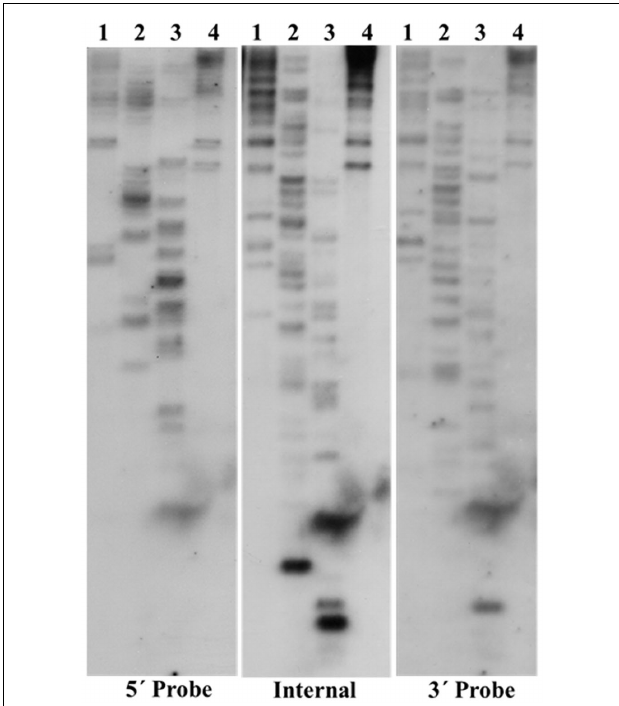
FIGURE 2 | DNA gel blot investigating TCUP copy number. B73 genomic DNA was digested with four different restriction enzymes. Each panel is the same DNA gel blot hybridized with different TCUP probes (see Materials and Methods). Lanes 1, Eco RI, 2, Hin dIII, 3, Ssp I, 4, Swa I.